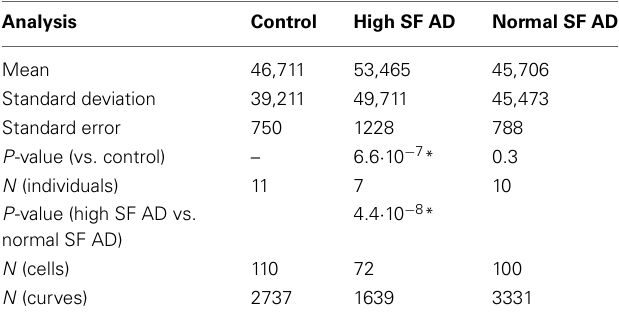
Table 3 | Descriptive statistics for elasticity (MPa) of red blood cell (RBC) membranes as obtained from the atomic force microscopy